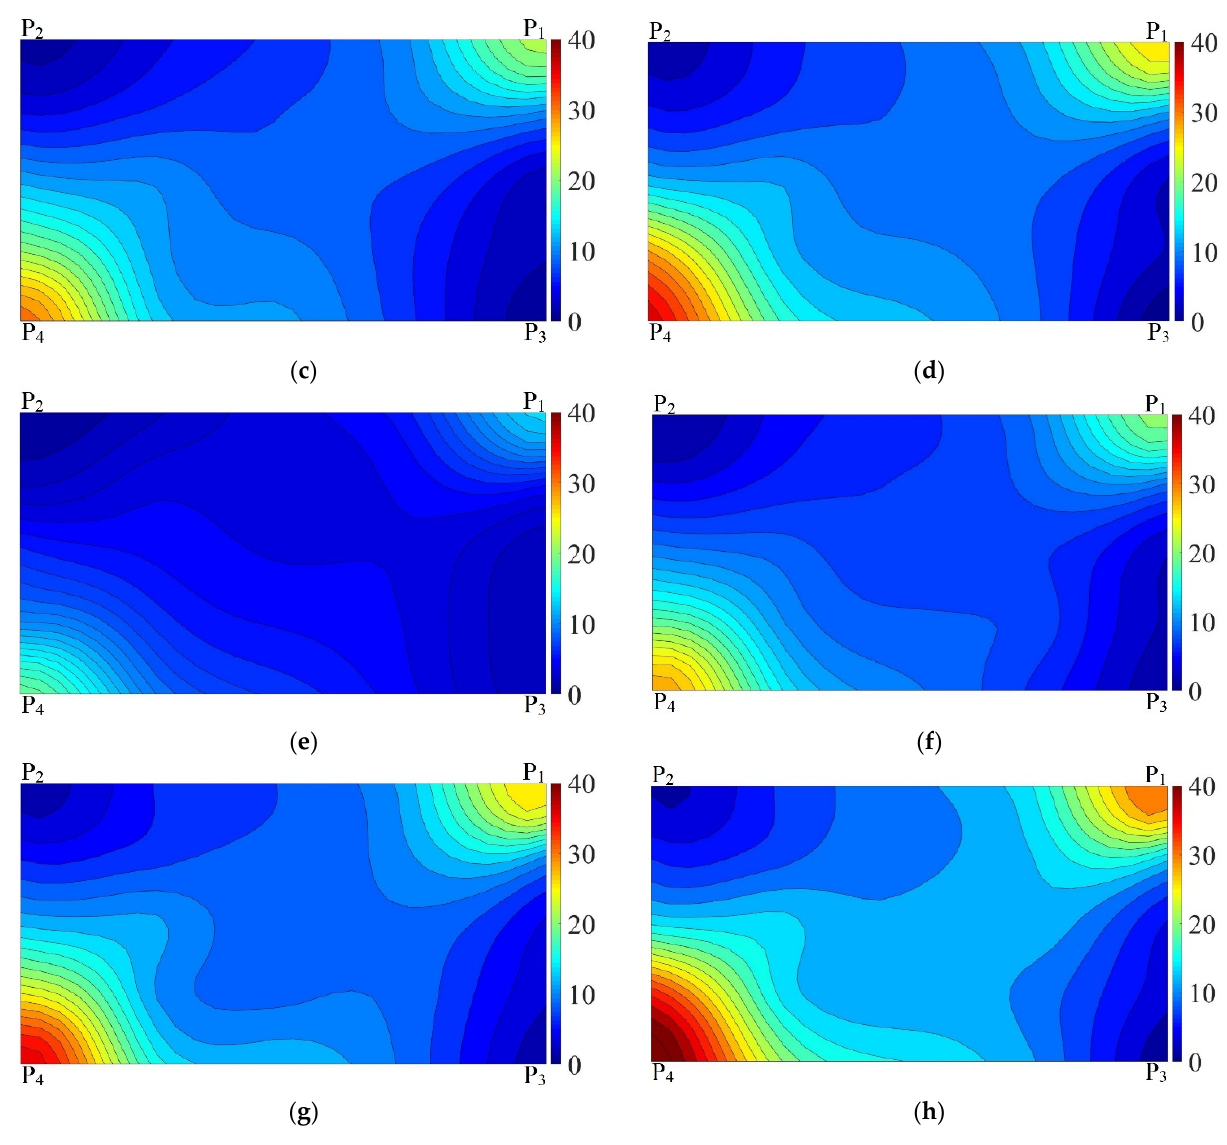
Figure 5. Cold-bending stress nephograms on the lower surface (MPa). ( a ) SJ1; ( b ) SJ2; ( c ) SJ3; ( d ) SJ4; ( e ) SJ5; ( f ) SJ6; ( g ) SJ7; ( h ) SJ8.